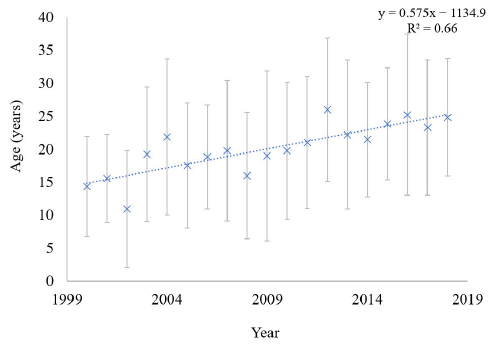
Figure 1. Average life span of cystic fibrosis (CF) patients in the 2000–2018 period.